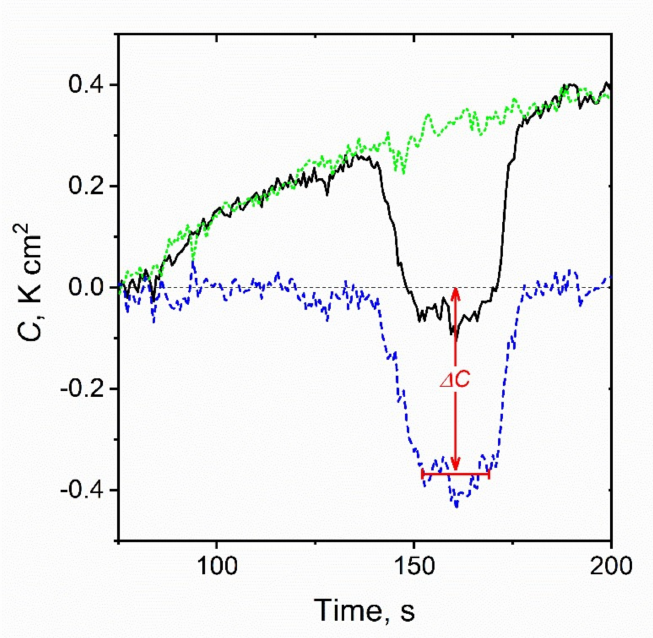
Figure 3. Trace of coefficient C for an experiment with a flame at φ = 0.65 and V g = 12.0 cm/s. The solid black line corresponds to data from the flame exposed to pulsed microwaves with a pulse duration of 50 µ s and a frequency of 1 kHz at an electric field of E RMS = 350 kV/m. The dotted green line displays the C -trace for the corresponding experiment without microwaves and the dashed blue line is the difference between the